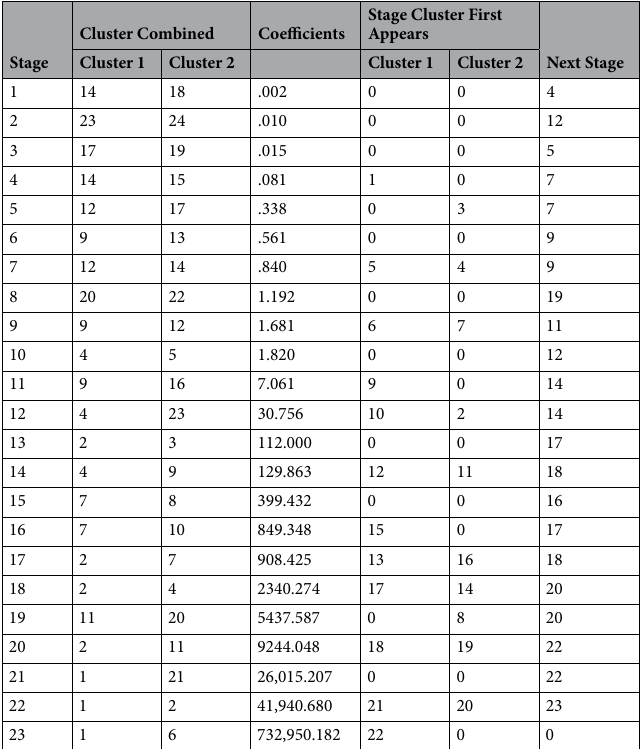
Table 8. Agglomeration schedule for different clusters obtained from soil analyses in the wetlands of Bamenda